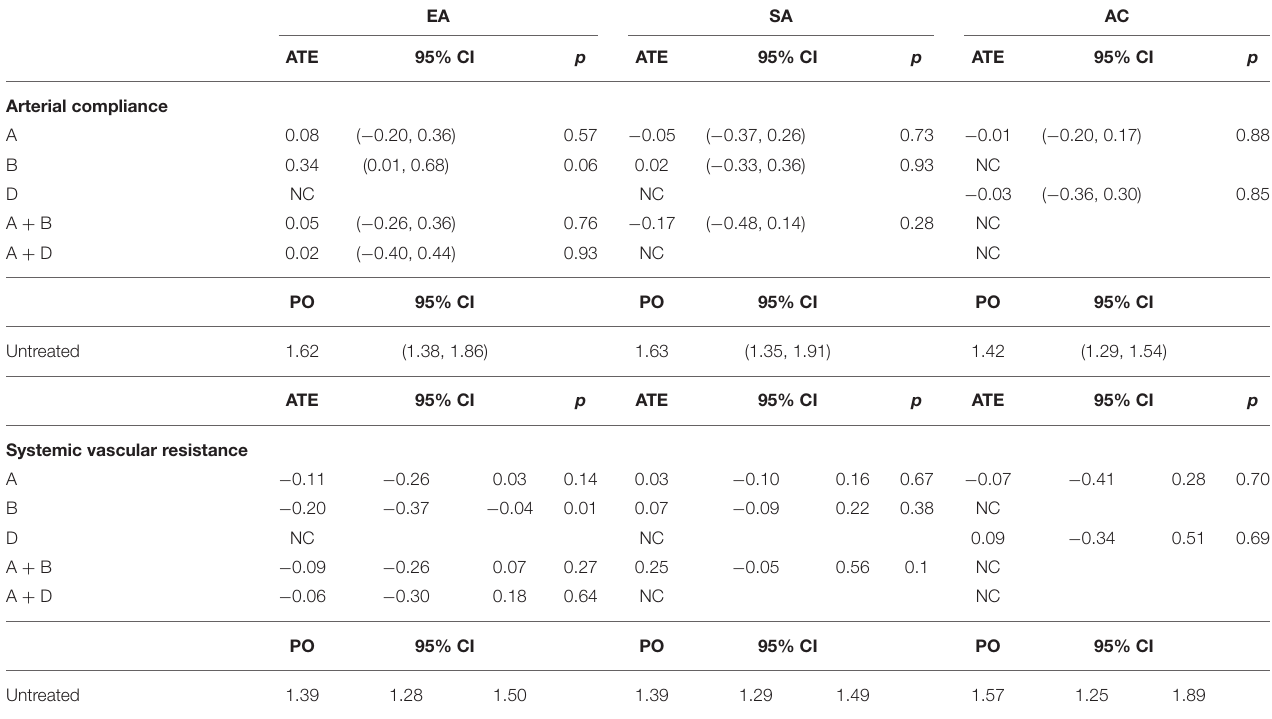
TABLE 3 | Treatment effects of antihypertensive regimens on arterial compliance and systemic vascular resistance by ethnicity. EA SA